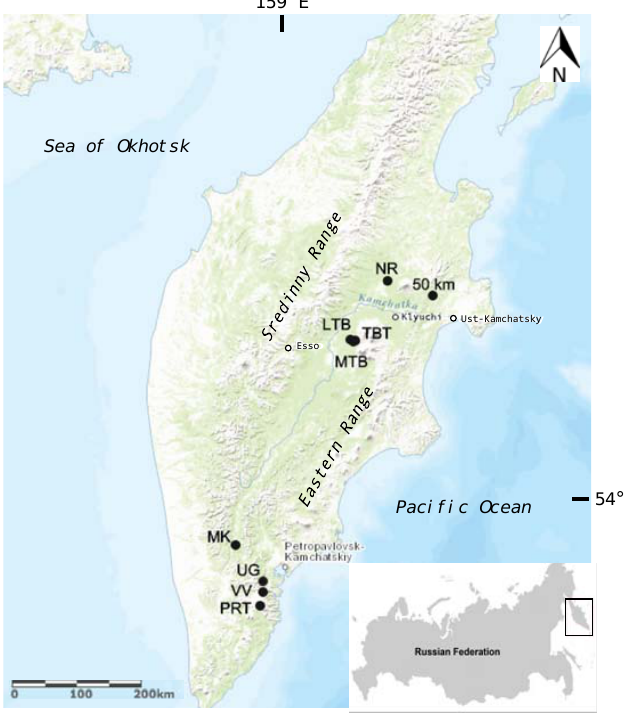
Figure 1. Locations of tree-ring chronology sites on the Kamchatka Peninsula, Russia. Also shown are Klyuchi, Ust Kamchatsky and Petropavlovsk-Kamchtasky meteorological stations that were used in comparisons with ring-width series. NR: North Road; LTB: Lower Tobalchik Volcano; TBT: Tobalchik Volcano; MTB: Mid-Tobalchik Volcano; MK: Malkee; UG: Garchche Sopa; VV: Viluchi Volcano; PRT: